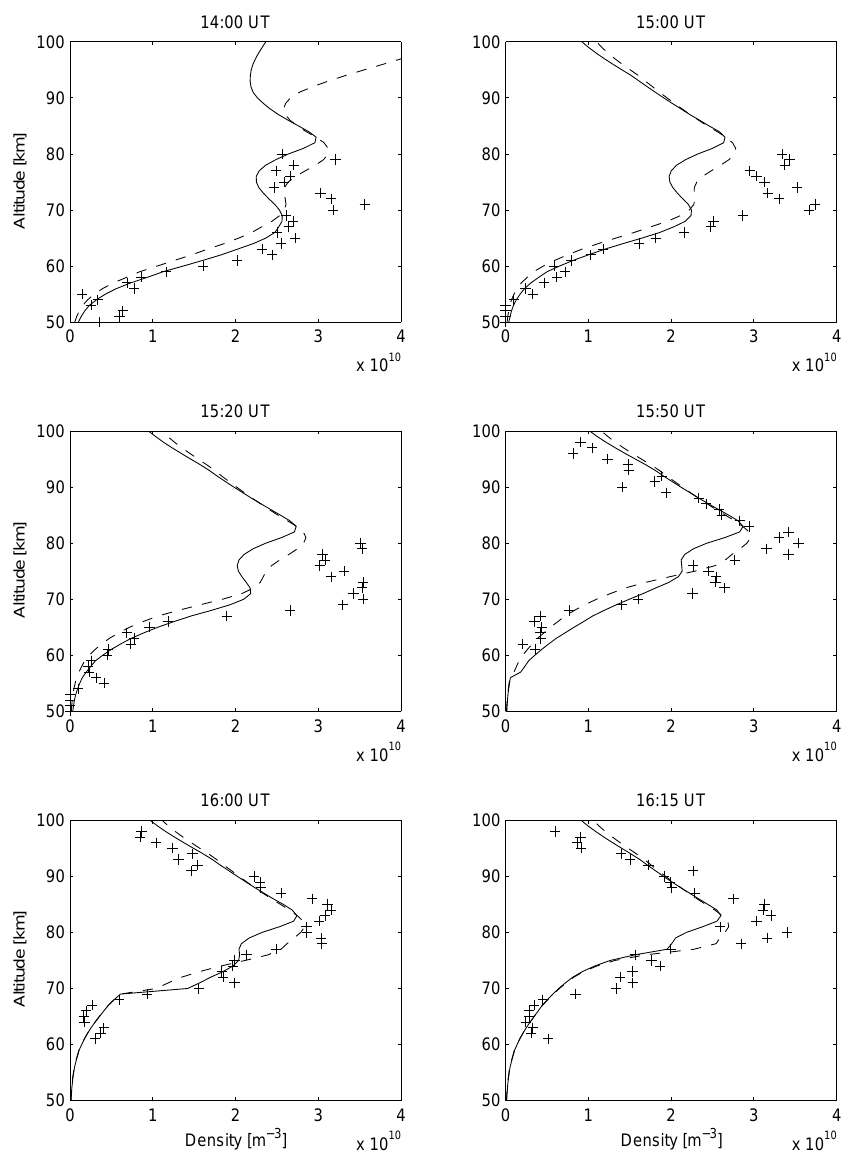
Fig. 9. Raw electron density profiles for selected times before, during, and after the sunset of 23 October. EISCAT measurements (+), as well as modelling results with model-determined NO (solid line) and with manually increased NO (dashed line), are shown. occurs, which is related to the negative charge